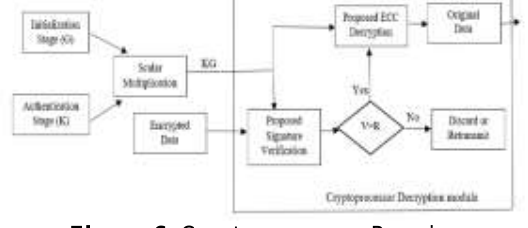
Figure 6. Cryptoprocessor